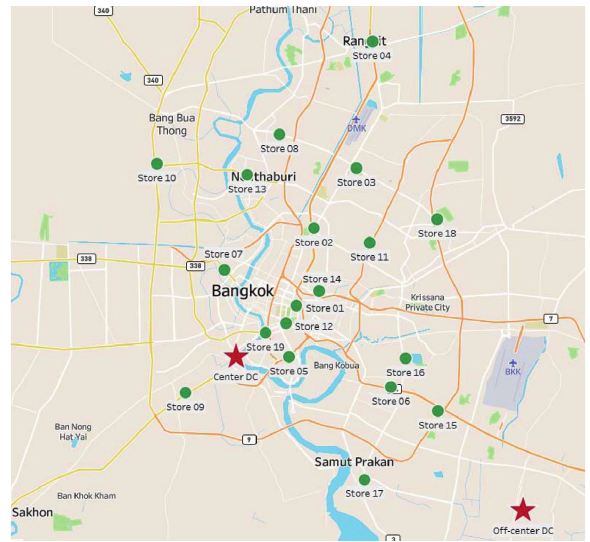
Figure 5: Example of forbidden transshipment